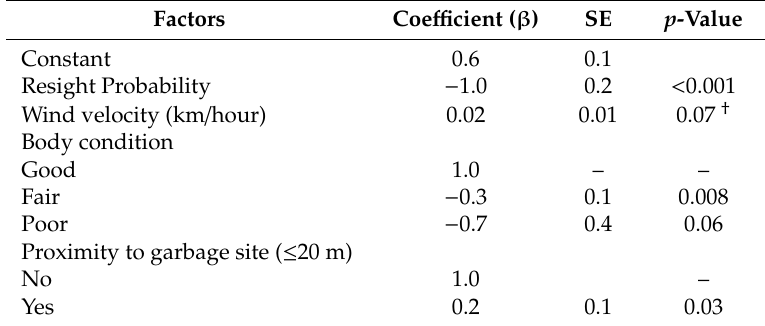
Table 4. Final multivariable model of predictors that significantly influenced the number of FRD sighted together (1–5) in a rural setting *.